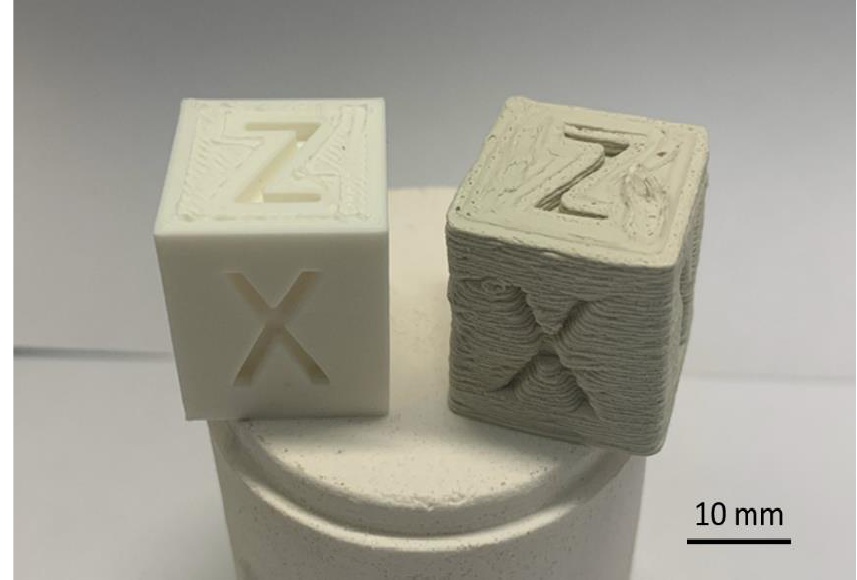
Figure 15. PLA ( left ) and 50Al 2 O 3 /50PLA ( right ) composition printed cubes.